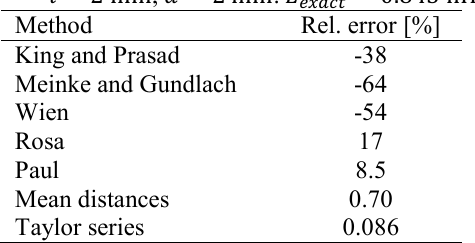
Table 1: Errors of the various methods